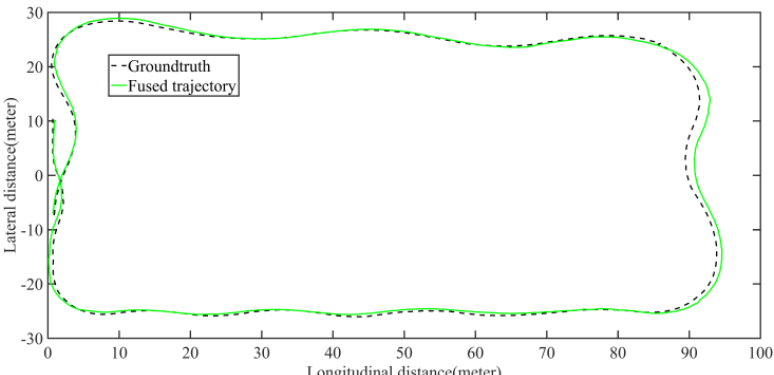
Figure 23. Field test NO.2. One lap under curve driving scenario localization test in prior point cloud map. The white points in the figure are the point cloud map built by the offline mapping process, the red line is the trajectory of LiDAR matching results, the orange line is groundtruth, and the blue line is the fused trajectory.